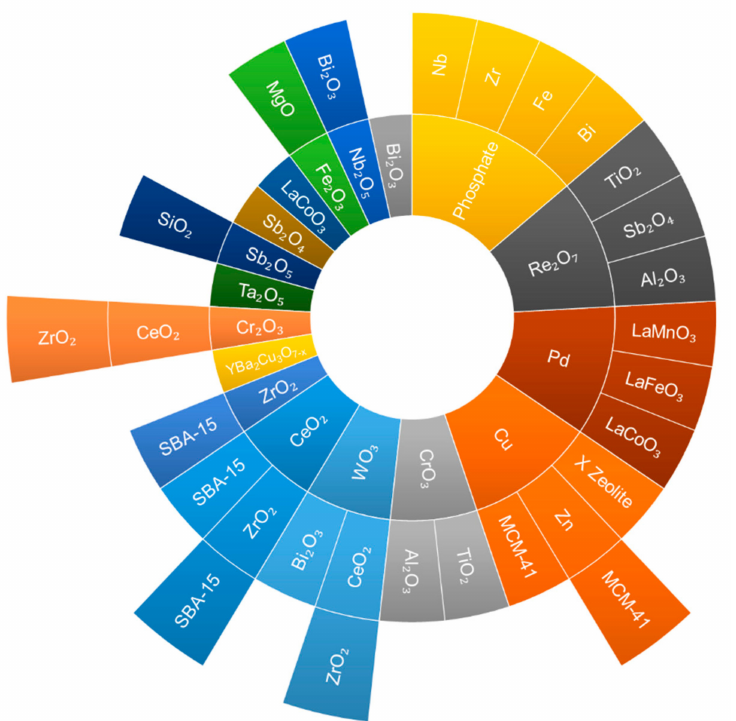
Figure 15. Solar plot for catalysts not containing V or Mo showing main components (inner circle), secondary component or support material (middle circle), and tertiary component or support material (outer circle). Oxygen may be present without it being